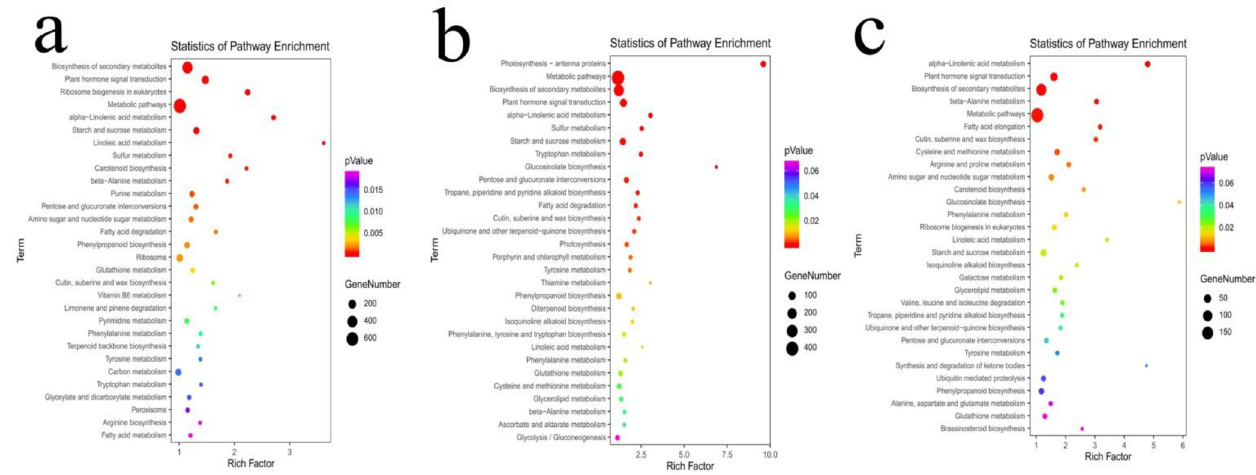
Fig 7. The top 30 KEGG pathway enrichments of DE genes in rapeseed buds. a-c: 1258A_SB vs_1258A_MB, P5A_SB_vs_P5A_MB and P26R_SB_vs_P26R_MB KEGG pathway enrichment. The size of each circle represents the number of significant DE genes enriched in the corresponding pathway. A pathway with a p -value < 0.05 is considered to be significantly